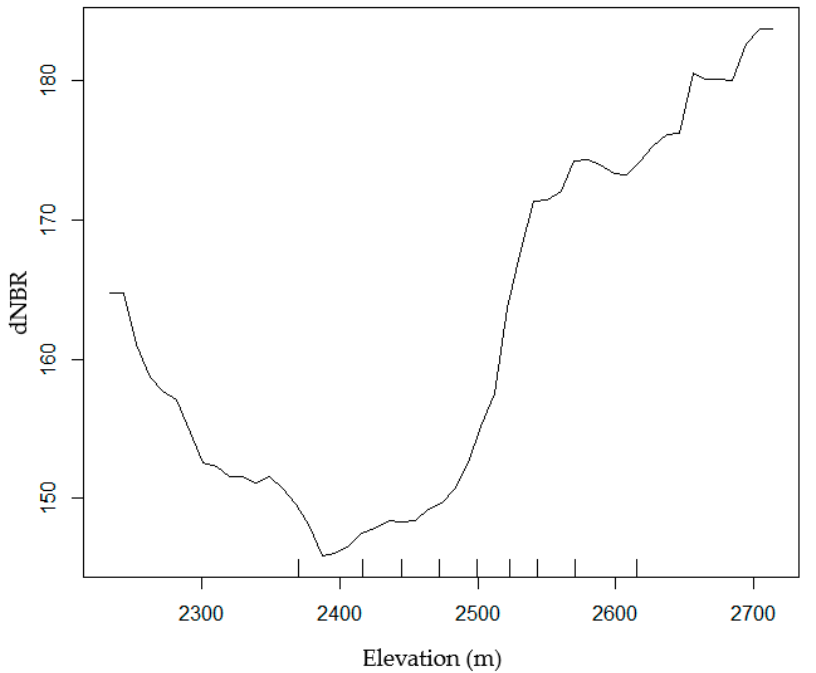
Figure 11. The likelihood of encountering high fire severity increases along the elevation gradient. There was also more high severity in the pinyon-juniper forest cover class near the rim, but the area that burned was relatively small in this vegetation type.